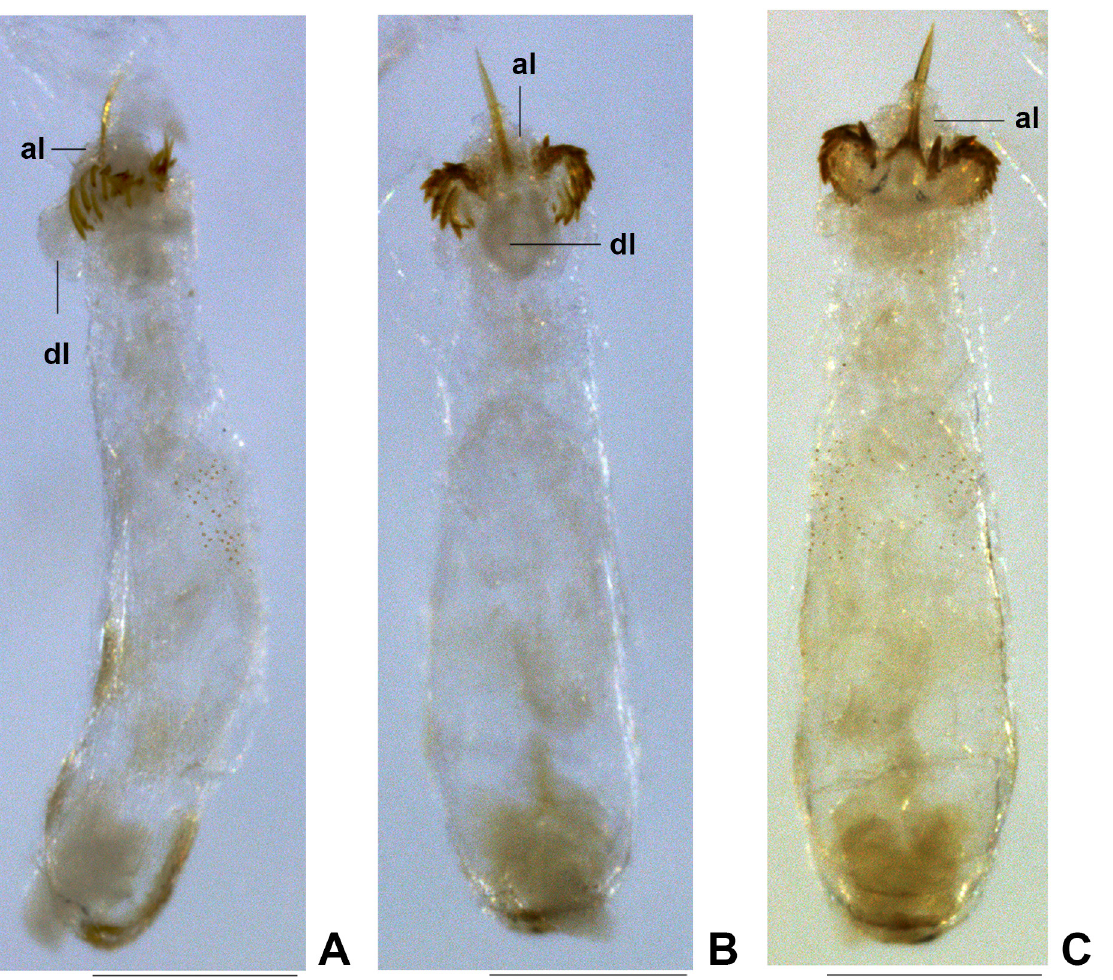
Fig. 10. Chinoperla nigrifrons (Banks, 1939), ♂ from Mount Yinggeling (HIST). A . Aedeagus, lateral view. B . Aedeagus, dorsal view. C . Aedeagus, ventral view. Abbreviations: see Material and methods. Scale bars = 0.25